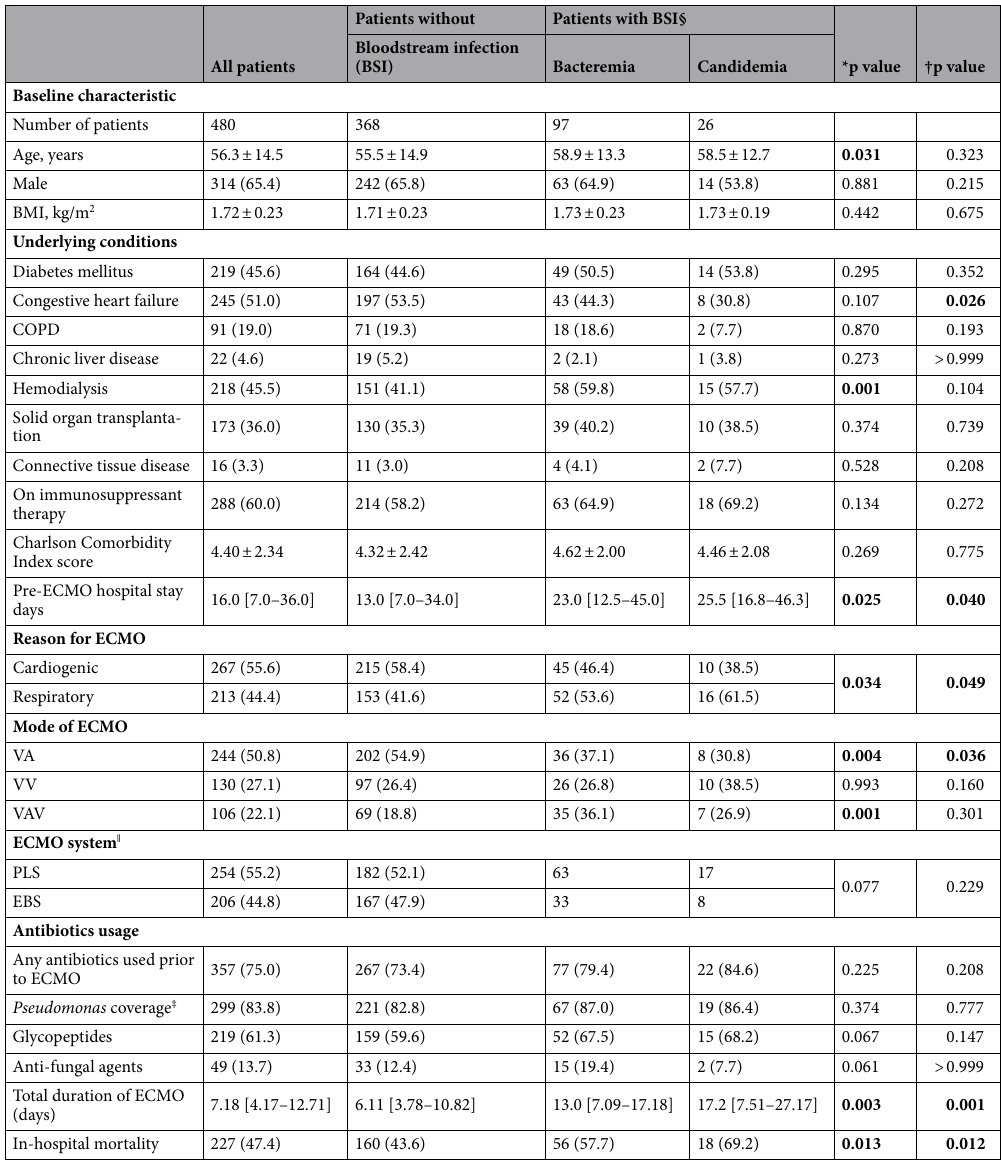
Table 1. Comparison between the bacteremia and candidemia groups. Data are expressed as number(percent), average ± standard deviation, or median [25% and 75%]. p values with statistical significance is shown in bold text. BMI body-mass index, COPD chronic obstructive pulmonary disease, ECMO extracorporeal membrane oxygenation, VA veno-arterial, VV veno-venous, VAV veno-arterial-venous, PLS prolonged life support, EBS emergency bypass system, BSI bloodstream infection. *p value is used to compare patients without BSI and patients with bacteremia. † p value is used to compare patients without BSI and patients with candidemia. ‡ Antibiotics with Pseudomonas coverage: piperacillin/tazobactam, cefepime, ceftazidime, imipenem, meropenem, ciprofloxacin, levofloxacin, and aztreonam. § 11 patients developed both bacteremia and candidemia during ECMO support. ‖ ECMO system unknown (n =